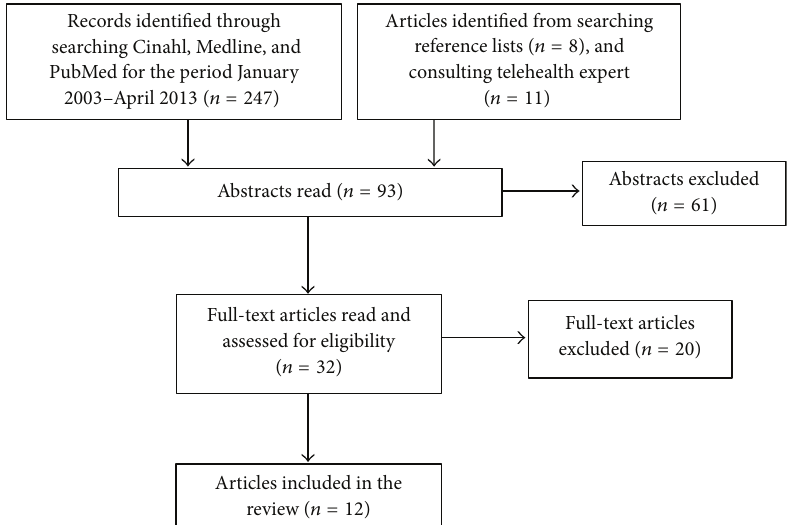
Figure 1: Flow diagram of study selection